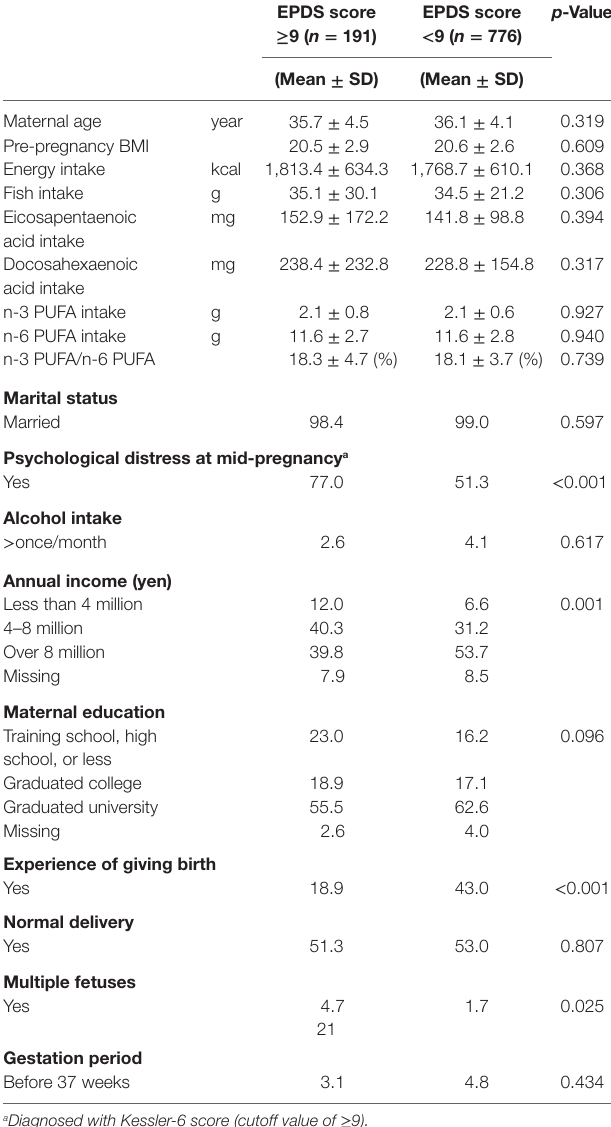
TaBle 1 | Characteristics of participants with and without depression [Edinburgh Postnatal Depression Scale (EPDS) score ≥ 9] at 1 month after